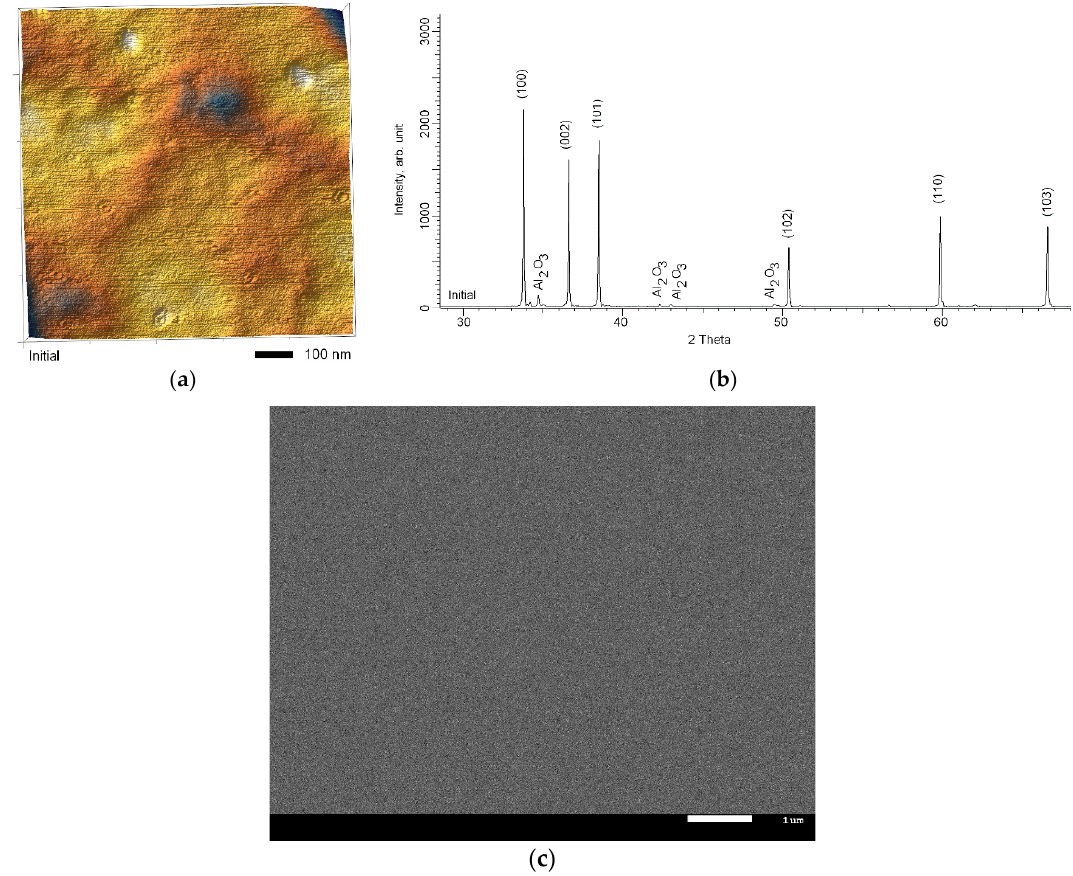
Figure 1. ( a ) AFM image of the surface of initial sample; ( b ) X-ray diffractogram of initial sample; ( c ) SEM image of the surface of initial sample .